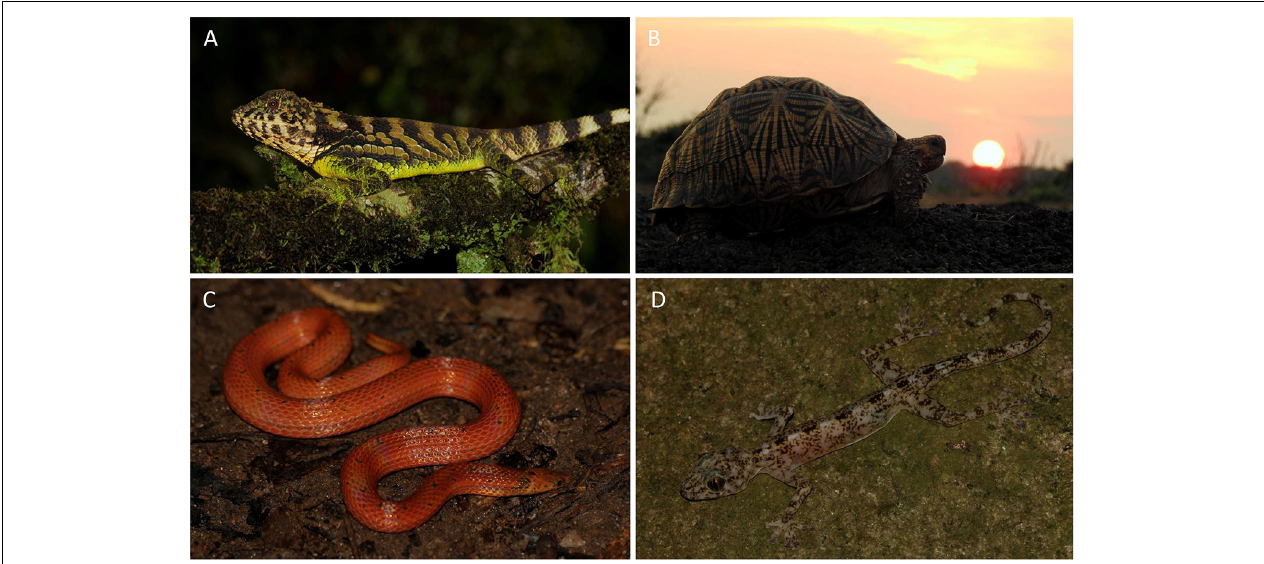
FIGURE 1 | Climatically restricted and threatened reptile species in Sri Lanka. (A) Ceratophora erdeleni –a critically endangered and endemic lizard species restricted to the 80 km 2 land area in Rakwana hill zone. (B) Geochelone elegans –a near threatened land tortoise that is found in Dry and Intermediate zone. (C) Aspidura brachyorrhos –a vulnerable and represent an endemic genus of non-venomous snake species that is found in Central Heighland zone. (D) Calodactylodes illingworthorum –a vulnerable and endemic gecko found in Uva Savannah zone (please refer to the reptile zone map in Figure 2A